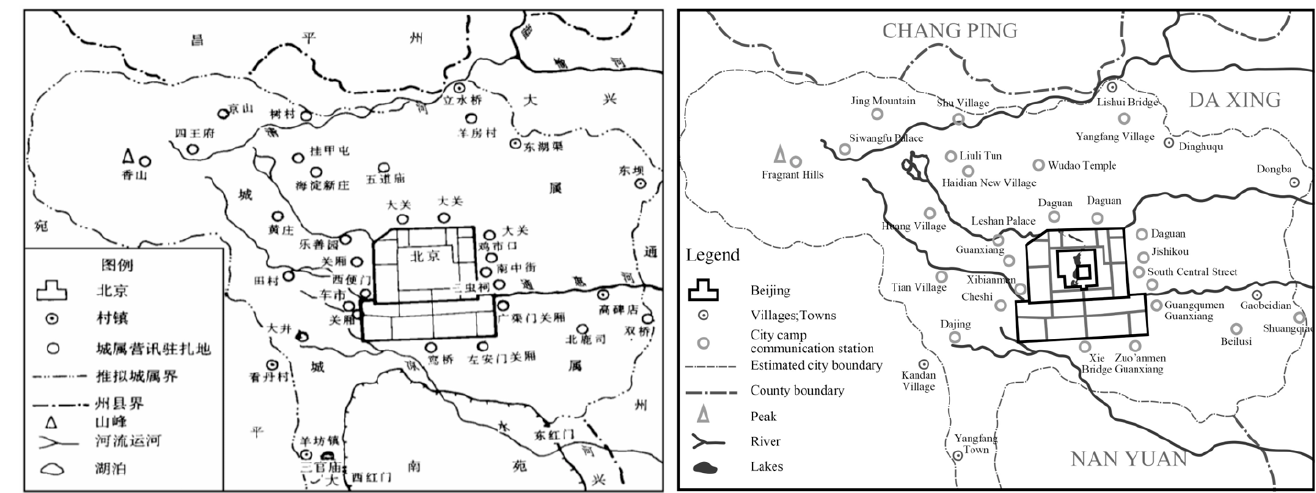
Figure 5. Simulated boundary under the jurisdiction of the Beijing Masters Patrol Camp [15]. (Chinese original version, English redrawn version)